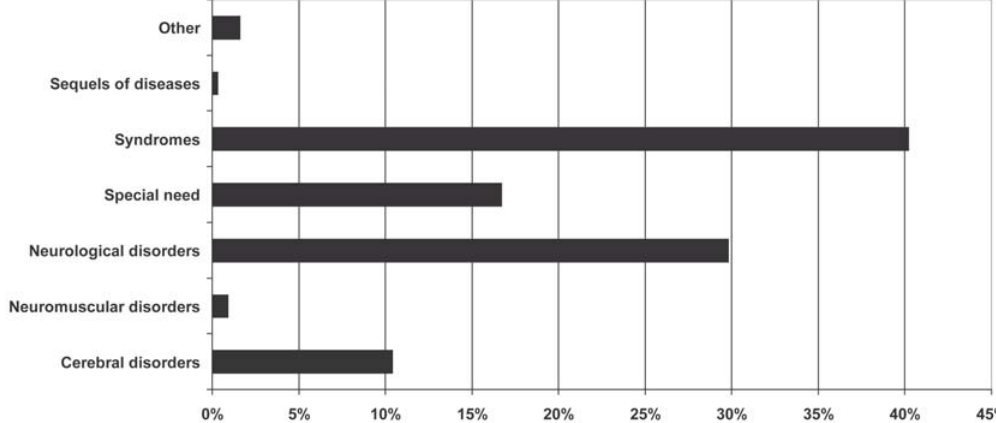
FIGURE 3- Histogram of dental and maxillomandibular alterations and anomalies for the different groups of neuropsychomotor disorders (in percentage)